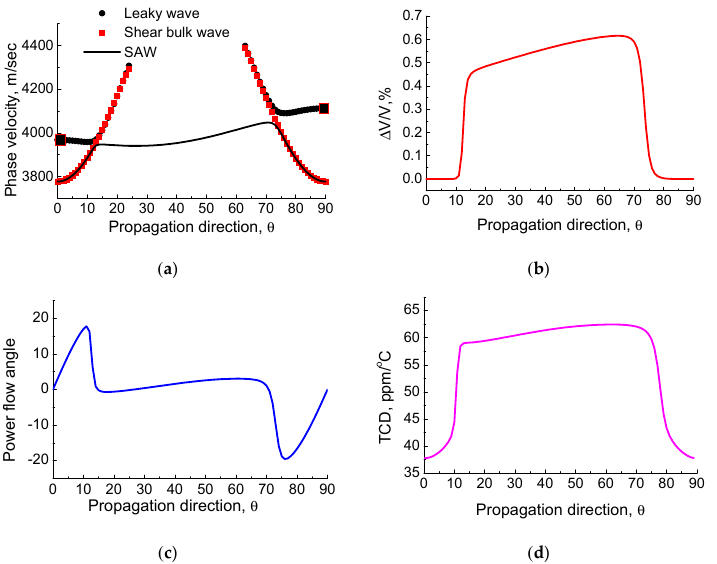
Figure 2. The propagation direction dependence of SAW parameters from the X-axis on the Z-cut of KTP: ( a ) phase velocity; ( b ) Δ V/V; ( c ) power flow deflection angle (degrees); and ( d ) TCD. The dark rectangle denotes the pseudo-surface wave solution. The SAW velocity Δ V/V, power flow